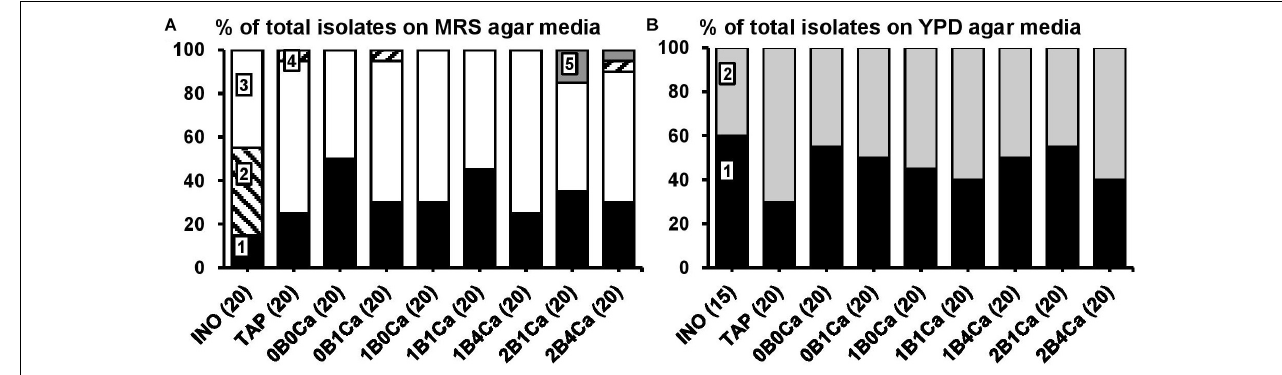
FIGURE 1 | Culture-dependent species diversity on the water kefir grains of the inoculum (INO) and eight water kefir fermentation series differing in the buffer capacity and calcium concentrations of the water used for fermentation at the end of backslopping step 8. The closest known type strains of the sequenced fragments are given. (A) Isolates from MRS agar media: 1, Lactobacillus paracasei (99% identity; GenBank accession no. AP012541); 2, Lactobacillus hilgardii (100% identity; accession no. LC064898); 3, Lactobacillus nagelii (99% identity; accession no. NR112754); 4, Lactobacillus harbinensis (100% identity; accession no. NR113969); and 5, Leuconostoc pseudomesenteroides (99% identity; accession no. LC096220). (B) Isolates from YPD agar media: 1, Saccharomyces cerevisiae [LSU (99% identity; accession no. KC881066) and ITS (99% identity; accession no. KC881067)]; and 2, Dekkera bruxellensis [LSU (99% identity; accession no. AY969049) and ITS (99% identity; accession no. NR111030)]. LSU, large subunit rRNA gene; ITS, internal transcribed